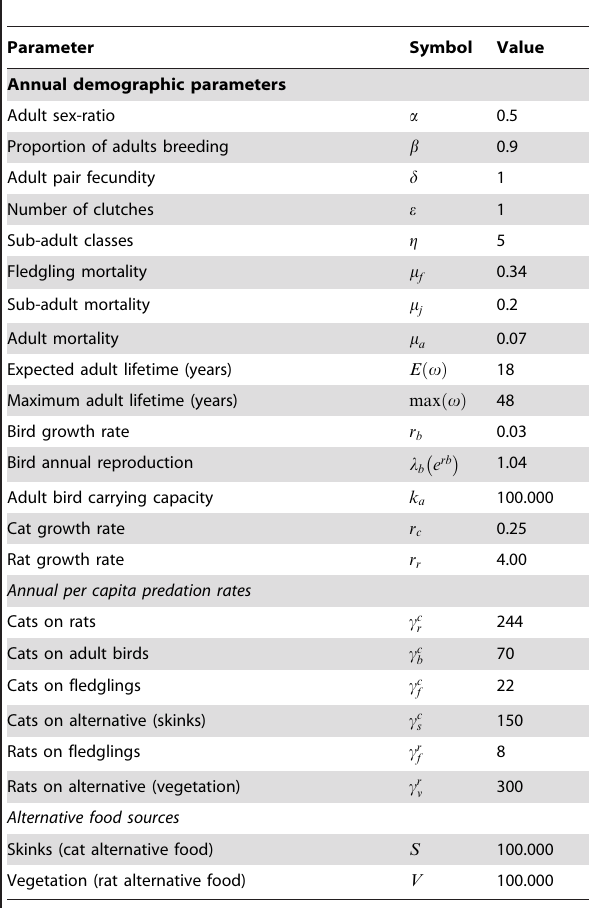
Table 1. Biological parameters used for the model (Russell et al.